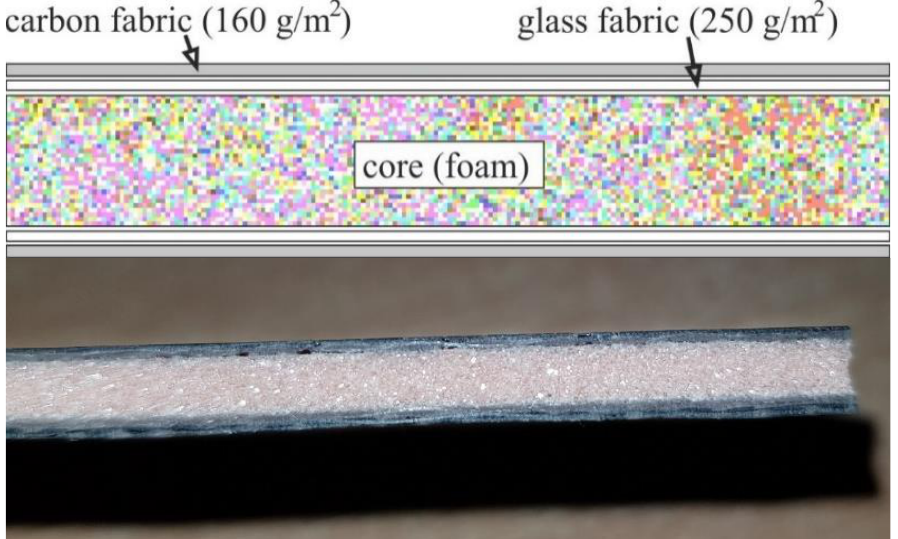
Figure 1. Structure of the sandwich composite used in research. Table 1. L 285 MGS resin